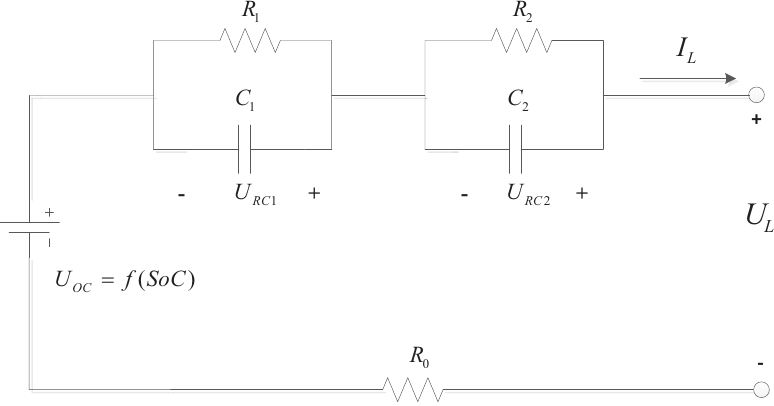
Figure 7. A schematic diagram of RC model with